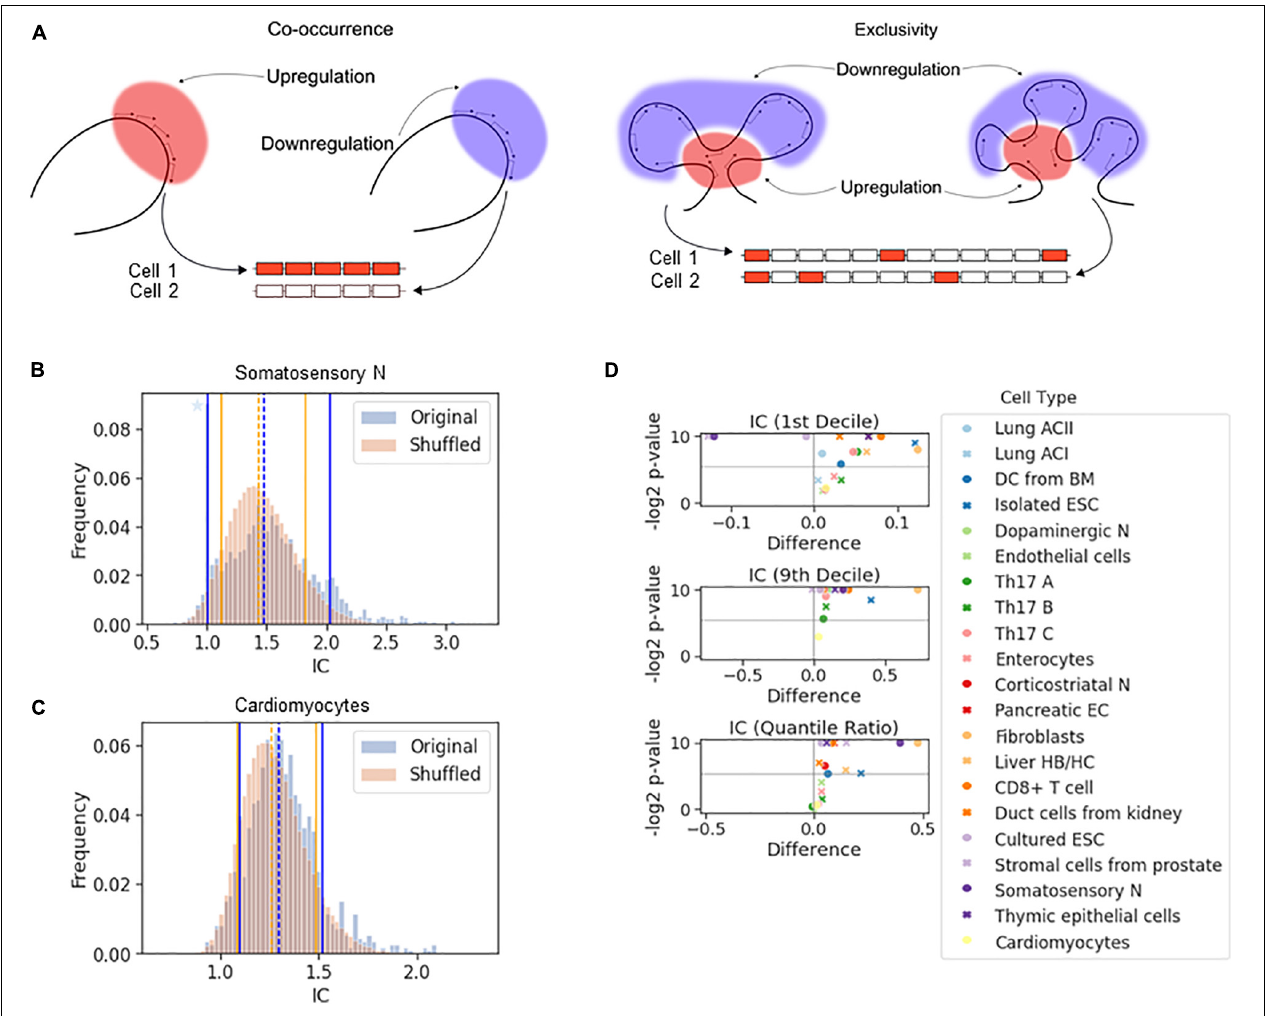
FIGURE 2 | The effect of chromosomal adjacency on stochastic gene choice. (A) Schemes showing examples of how the two major forms of stochastic gene choice, concurrence and exclusivity, can arise from alternative chromosomal configurations. (B,C) The IC distributions calculated from the original and the shuffled genomes of the somatosensory neurons (B) and cardiomyocytes (C) . Segmentation size: 14 genes. The blue star denotes a high bar in the histogram hidden by the full line. The location of the 1st (full line), 5th (dashed line) and 9th (full line) deciles is given in the order of original and reshuffled distribution, followed by the P -values for the differences: 1.00, 1.48, 2.02; 1.12, 1.44, 1.82; 0.001, 0.016, 0.001. (B) 1.10, 1.29, 1.52; 1.09, 1.26, 1.49; 0.217, 0.002, 0.137 (C). (D) Volcano plots showing the difference of 1st decile, 9th decile and quantile ratio IC values between the original and the shuffled genomes, along with the corresponding P -values (permutation test, segment size: 14 genes). The gray horizontal line at 0.025 corresponds to a two-tailed significance level of